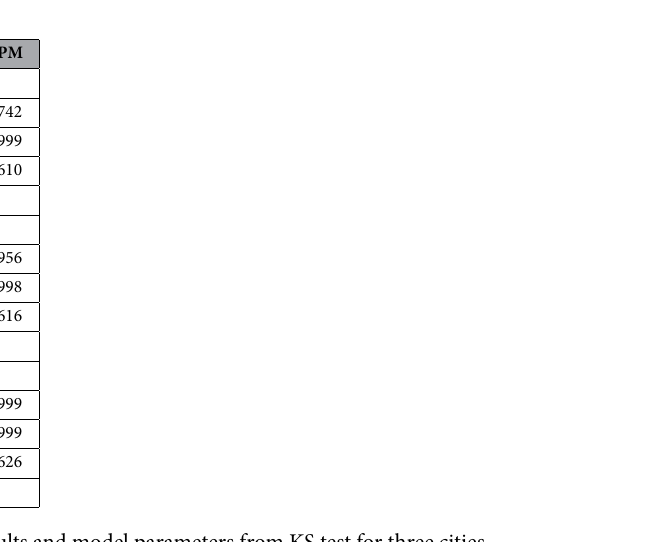
Table 2. Summary of fitted results and model parameters from KS test for three